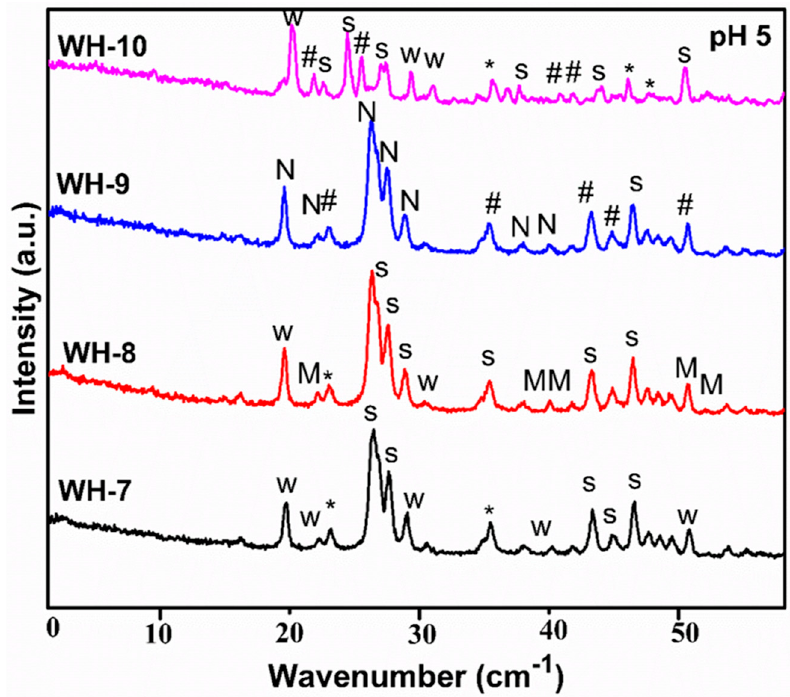
Figure 4. PXRD diffractograms of third batch of products (WH-7, WH-8, WH-9, WH-10) (S for Stanfieldite, W = Biological WH, M for Monetite, N for Newberyite, # for mixed CaP phases and * for β -TCMP/TCP).